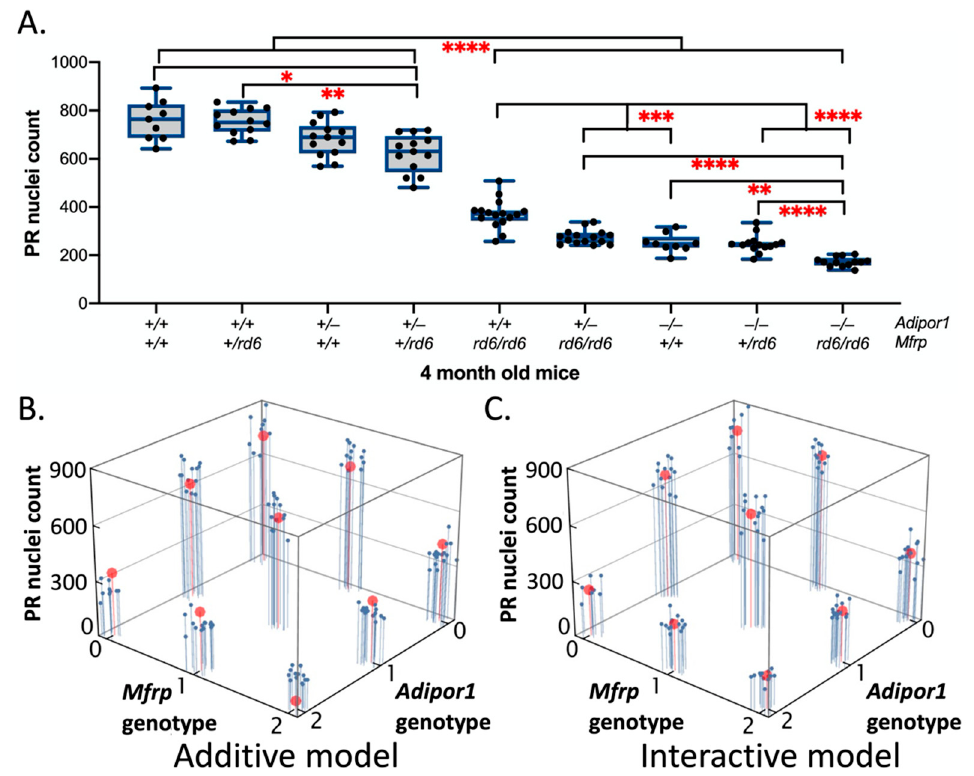
Figure 4. Photoreceptor degeneration in 4-month-old F2 mice from an ( Adipor1 + / − / Mfrp +/rd6 ) F1 intercross: ( A ) Using two-way factorial ANOVA, followed by Tukey’s HSD post-hoc analysis revealed statistically significant differences in PR degeneration between different genotypic possibilities of F2 intercross progeny. Absence of additive effect in single ( Adipor1 − / − / Mfrp +/+ , Adipor1 +/+ / Mfrp rd6/rd6 ) and double ( Adipor1 − / − / Mfrp rd6/rd6 ) gene homozygous mutants, as compared to the wild types ( Adipor1 +/+ / Mfrp +/+ ), confirmed the gene interaction effects. As no sex-based differences were found, data from both sexes were combined. * p < 0.05; ** p < 0.01; *** p < 0.001, and **** p < 0.0001. ( B ) Linear fit model without interactions and ( C ) linear fit model with interactions, showing actual data in blue and model predictions in red. The Adipor1 and Mfrp genotypes along the two axis represent independent variables, where the alleles are scored as: wildtype—0, heterozygous—1, and homozygous—2. The PR nuclei count along the third axis represents response variables. The model predictions fit the actual data better in the interactive model, so it is concluded that the interactive model has a better fit than the additive model, confirming an interactive effect. n = 9–15 per genotype.